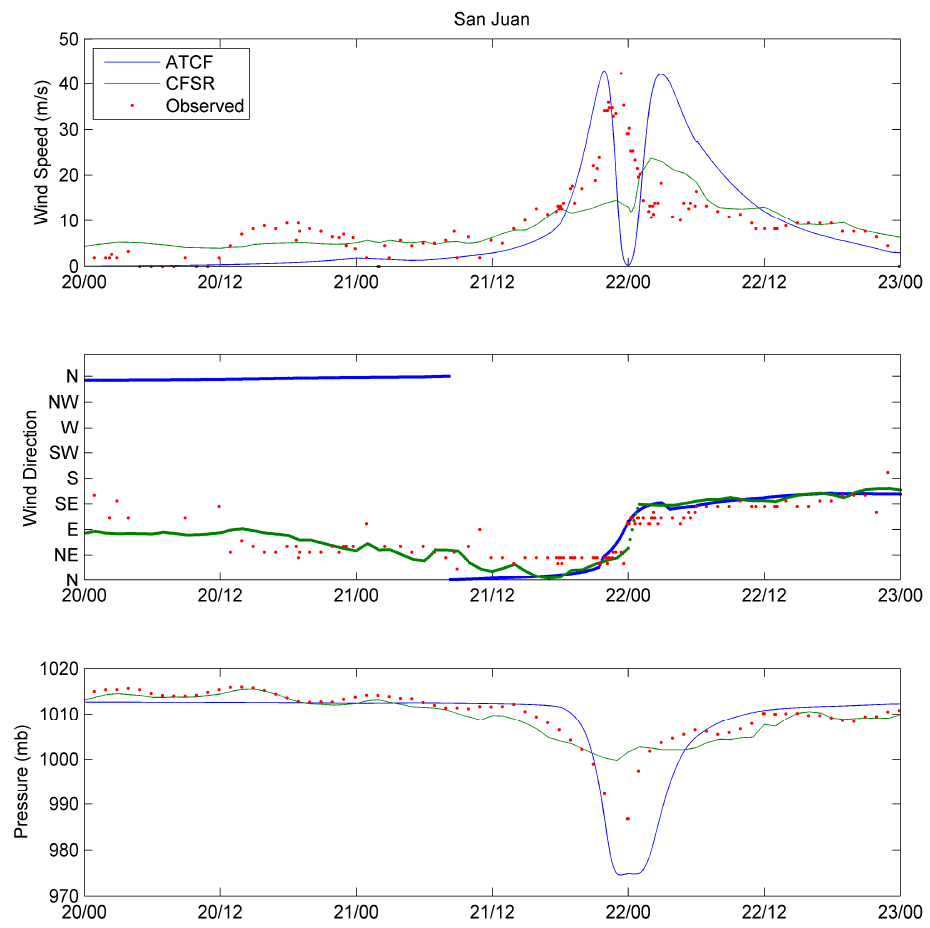
Figure 7. Observed (dots), parametric model (blue line) and CFSR (green line) wind speed ( top ), wind direction ( middle ) and atmospheric pressure ( bottom ) during Hurricane Georges at San Juan, Puerto Rico. The observed values were obtained from the NOAA 9755371 monitoring station at the San Juan Harbor. The plotted period is from 20 September 20 1998 0:00 UTC to 23 September 1998 0:00 UTC [51].